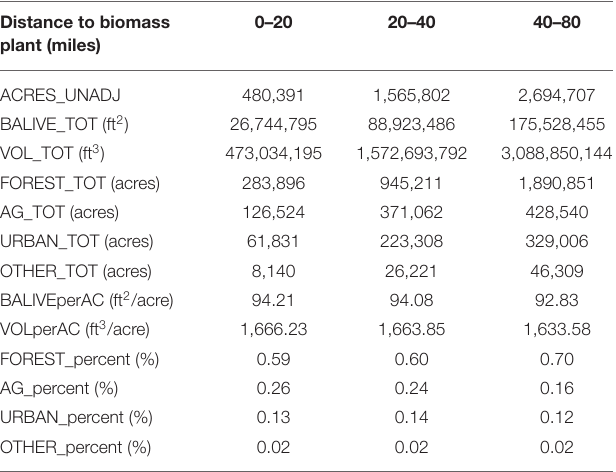
TABLE 1 | Population totals and per acre estimates for FIA basal area, net volume and land use variables derived for a series of concentric rings representing driving distances to a hypothetical biomass energy